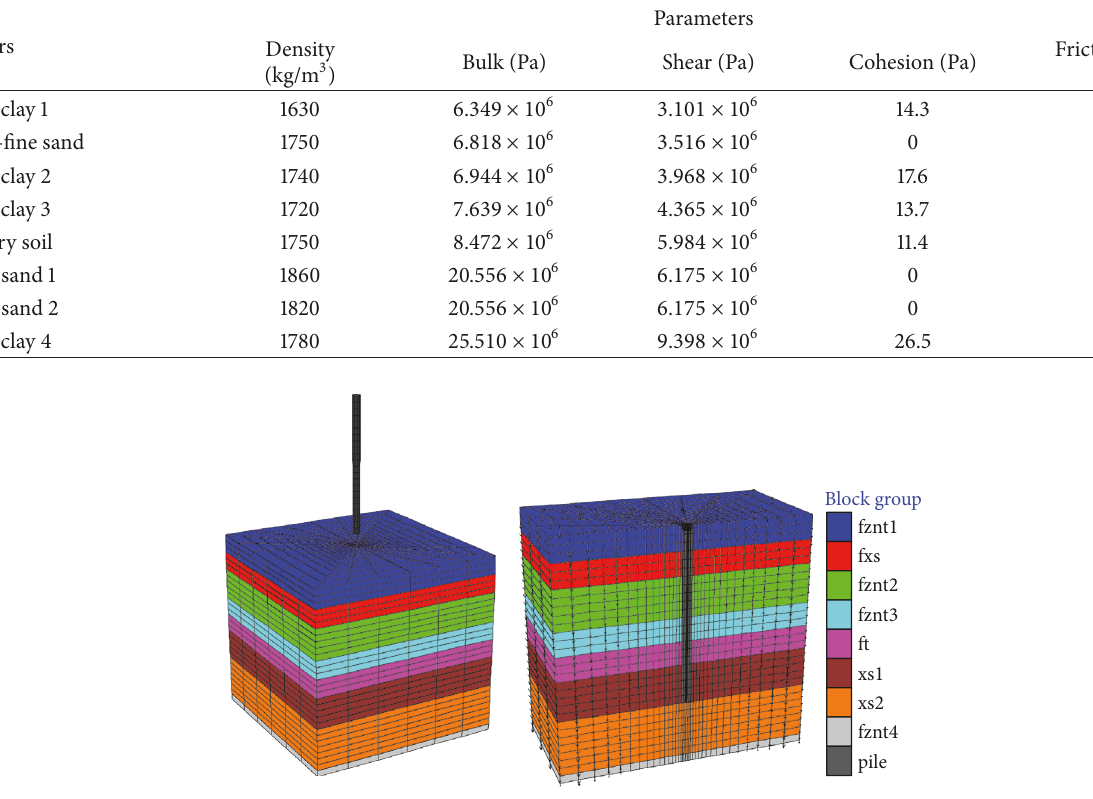
Table 1: Parameters of different layers of soil.